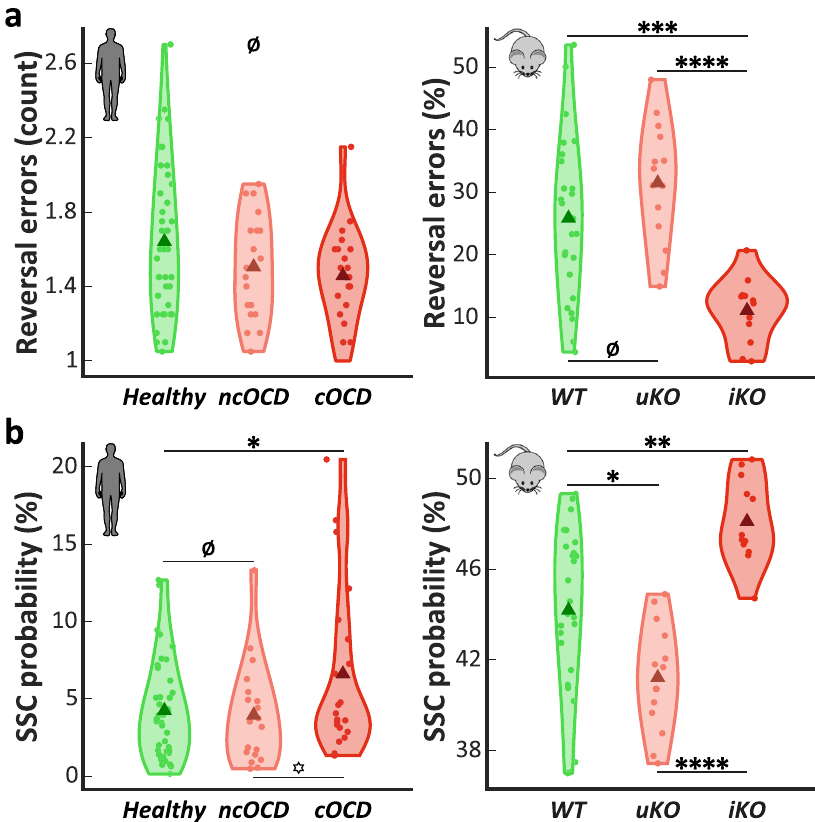
Fig. 4 An excessive response lability underlies the reversal learning de fi cit. a De fi cits of behavioral fl exibility found in both OCD “ checkers ” patients ( n = 21) and “ impaired ” KO mice ( n = 12) subgroups were not explained by a greater perseveration (in term of reversal errors). b Instead, both OCD “ checkers ” and “ impaired ” KO mice showed an increased SSC probability compared to other groups ( n = 19 “ non-checkers ” , 40 healthy controls, 14 “ unimpaired ” KO and 26 WT mice), suggesting a higher response lability. ncOCD: “ non-checkers ” . cOCD: “ checkers ” . uKO: “ unimpaired ” KO mice. iKO: “ impaired ” KO mice. Triangle: group mean. Dot: individual mean. Ø: BF